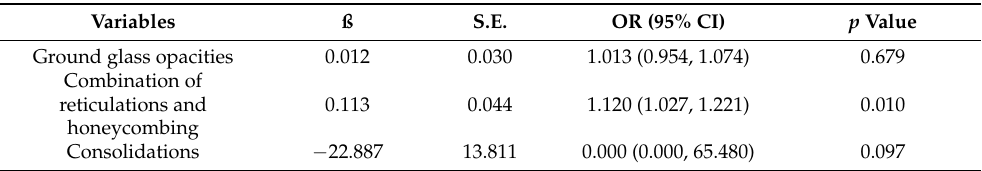
Table 4. Multivariate logistic regression analysis was used to determine the correlation between imaging features and glucocorticoid